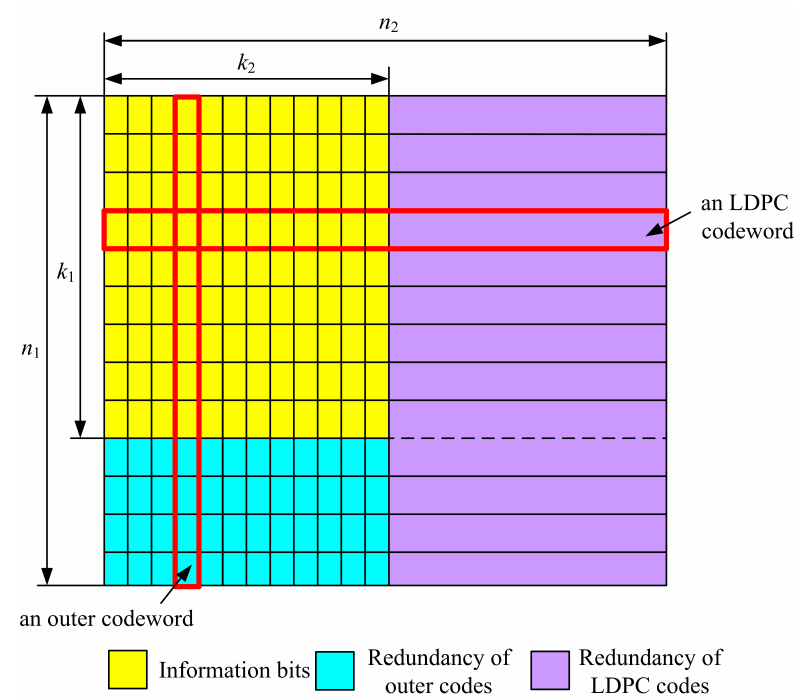
Figure 1. The product code structure using the LDPC code and high rate algebraic